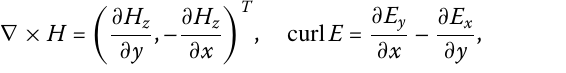
fiber layer (RNFL), namely the tendency of RNFL thinning in glaucoma and other